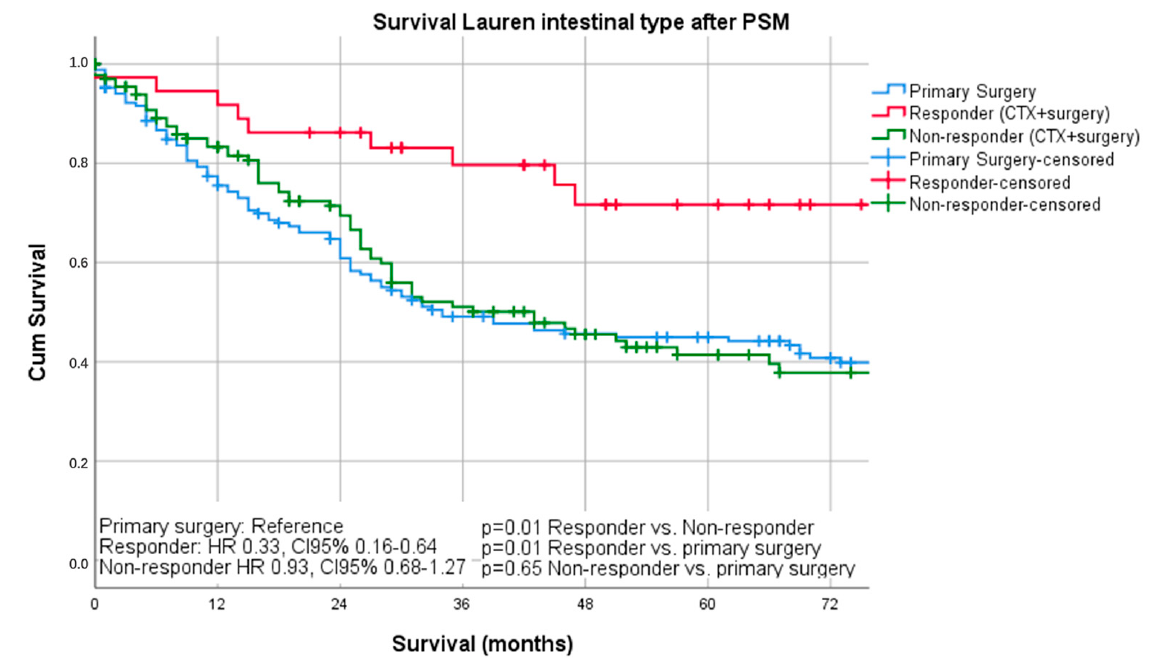
Figure 4. Survival curves for intestinal subtype after PSM differentiated by responders, non-responders, and surgery only.